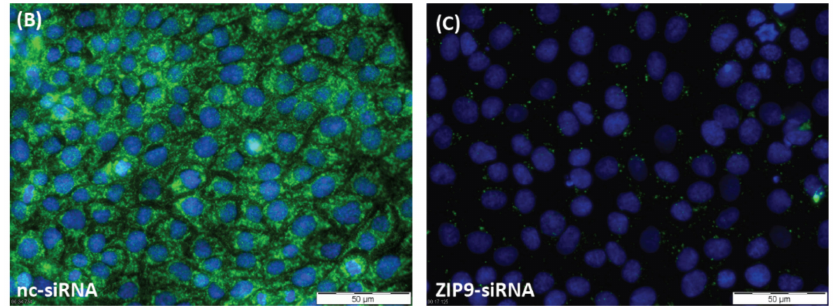
Figure 2. Detection of ZIP9 mRNA or protein in PASC1 cells. Cells were treated with either nc-siRNA or ZIP9-siRNA. ( A ) qRT-PCR showing expression of ZIP9-specific mRNA/cDNA. ( B ) Detection of ZIP9 protein by immunofluorescence before and ( C ) after silencing ZIP9-specific mRNA expression. Green fluorescence corresponds to ZIP9 and nuclei are stained